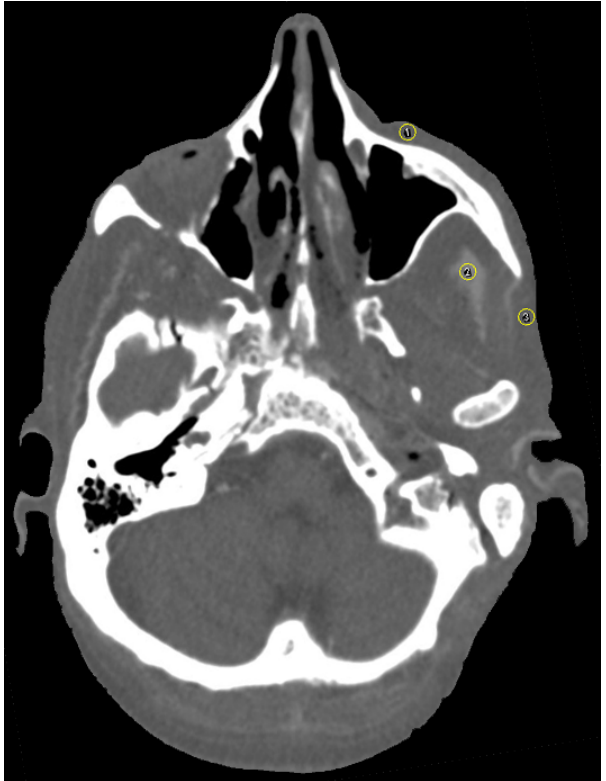
Figure 4. Axial view of selection of three circular regions of interest (ROI) in close proximity to the zygomatic implant using the ROI manager in ImageJ [(1) the zygomatic soft tissue, (2) the temporal muscle and (3) the parotid gland]. Plugins used were CT Window Level and SPICE-CT Package for Computed Tomography QC (Loveland, J.; 2011). HU window was set to soft tissue. Mean HU values were measured for all ROI to determine artifact occurrence.